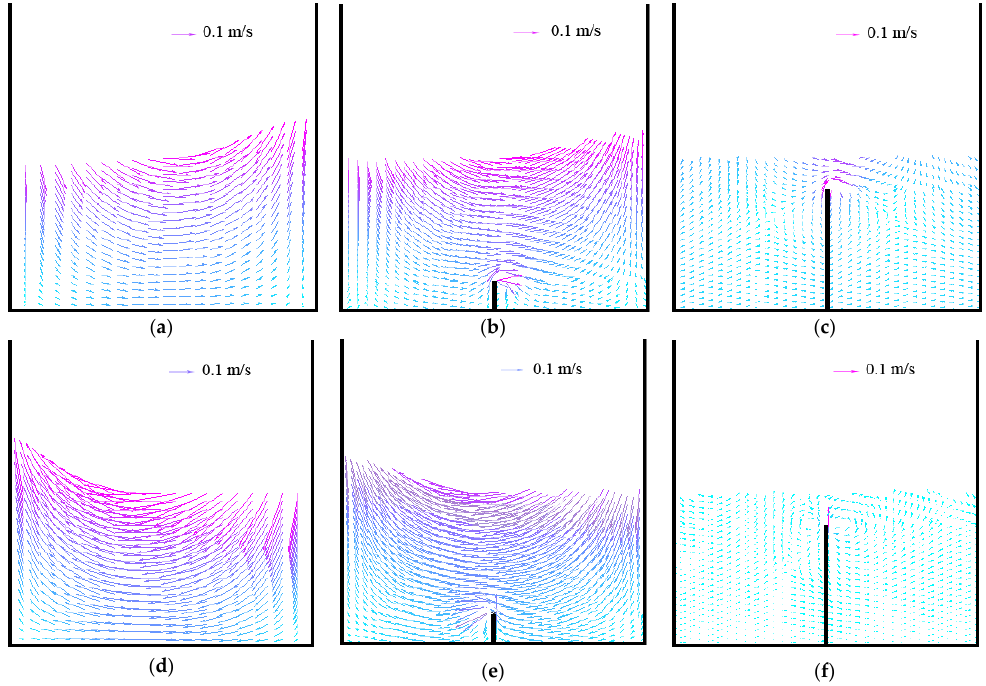
Figure 13. The fluid velocity fields of sloshing in a tank under different baffle heights at different time. ( a ) H =0.0 h , t = 5.8 s; ( b ) H = 0.2 h , t = 5.8 s; ( c ) H = 0.8 h , t = 5.8 s; ( d ) H = 0.0 h , t = 8.6 s; ( e ) H = 0.2 h , t = 8.6 s; ( f ) H = 0.8 h , t = 8.6 s.